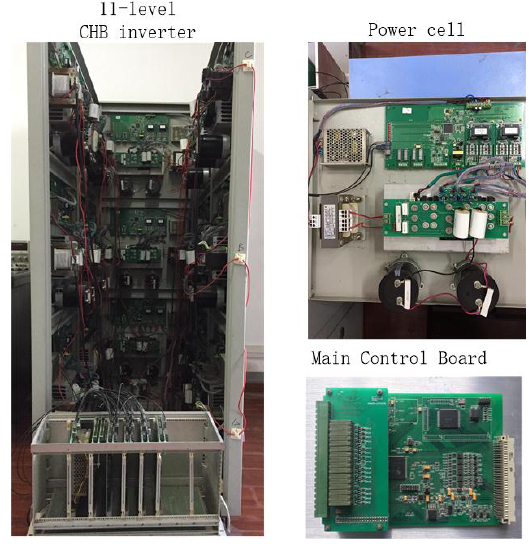
Figure 14. Picture of the experimental prototype.